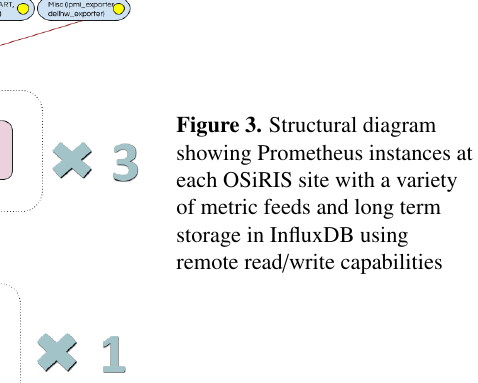
Figure 3. Structural diagram showing Prometheus instances at each OSiRIS site with a variety of metric feeds and long term storage in InfluxDB using remote read / write